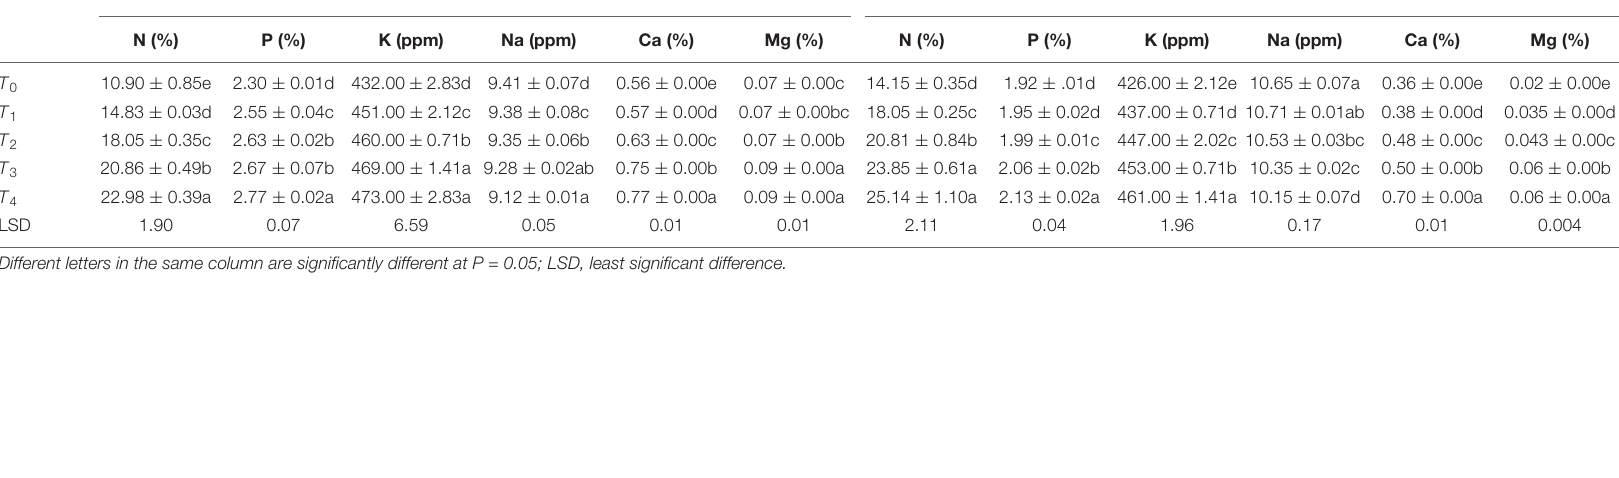
TABLE 4 | Chemical analyses of shoot and root tissues of Acacia modesta grown in different concentrations of quarry waste. Treatment Shoot tissues